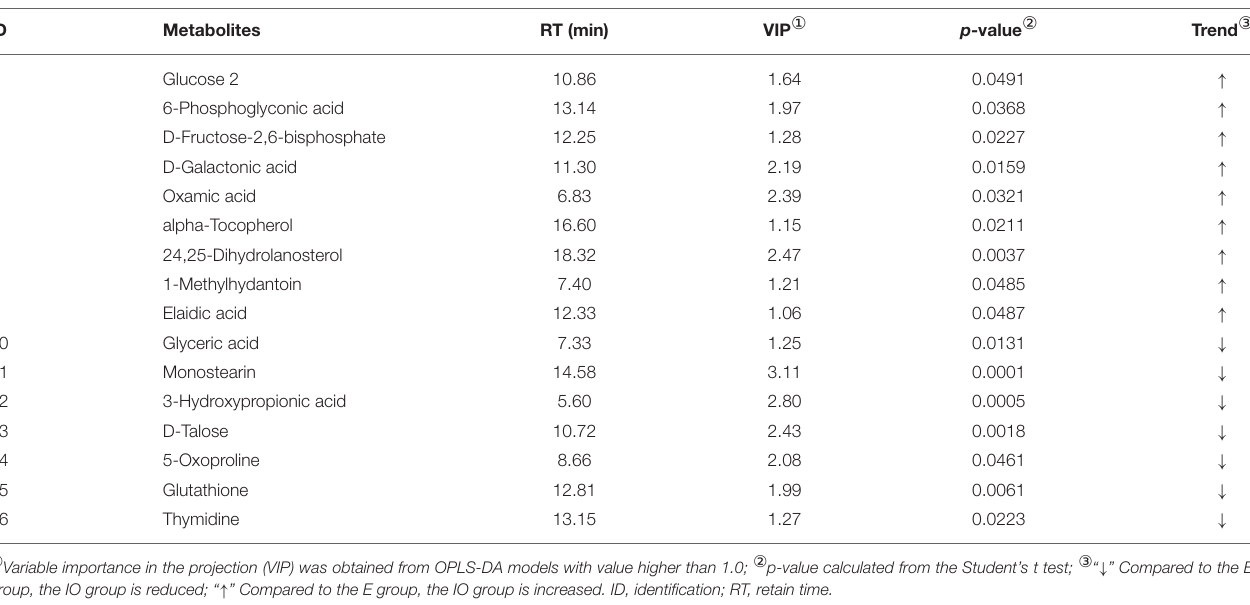
TABLE 2 | Differential metabolites in the serum of inactive ovaries and estrus cows.